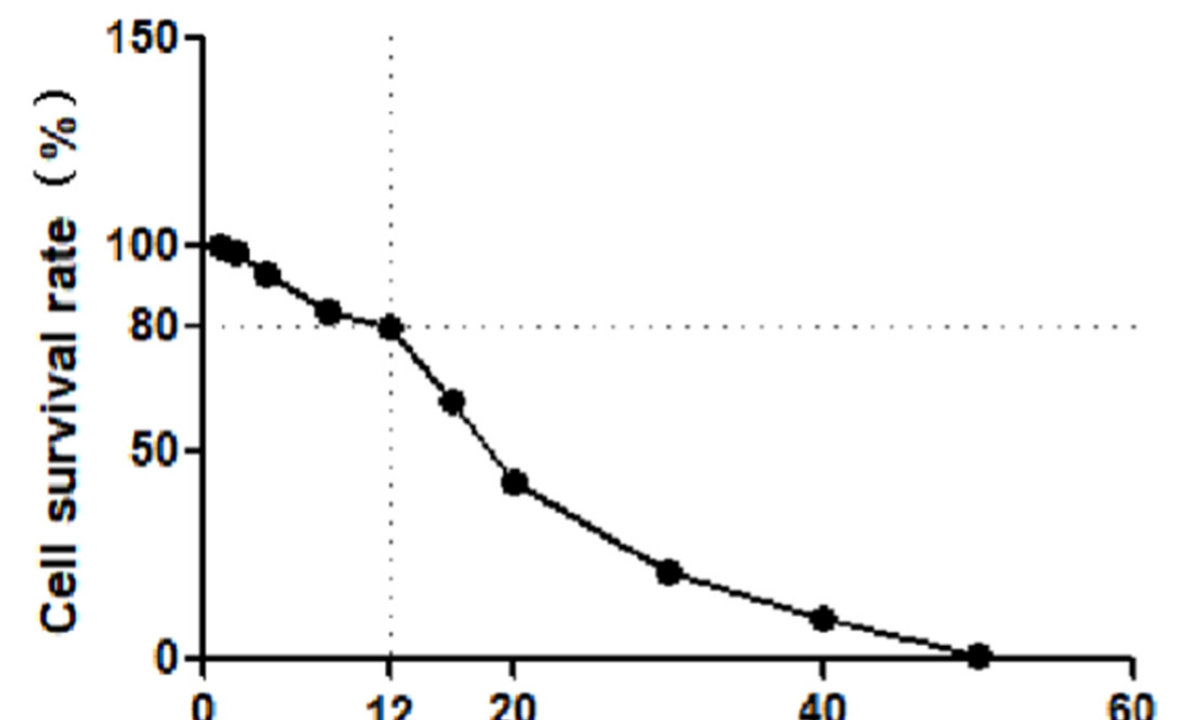
Figure 5. Effects of different concentrations of copper sulfate solution on the survival rate of RAW264.7 cell.